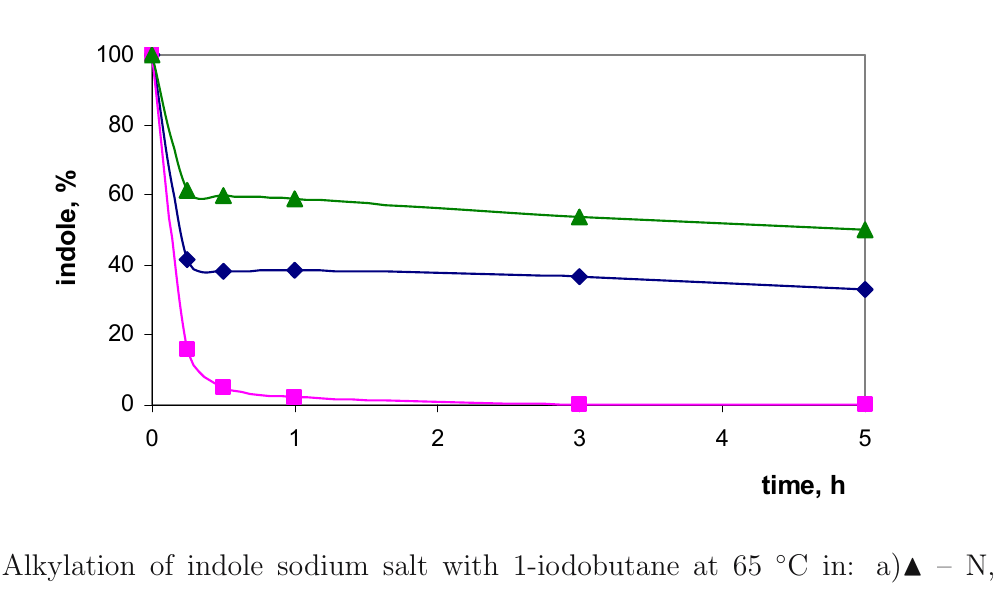
Fig. 2 Alkylation of indole sodium salt with 1-iodobutane at 65 ◦ C in: a) (cid:3) – N,N- dimethylformamide; b) (cid:2) – tetrahydrofurane; c) (cid:4) – ionic liquid [bmim] [Br].